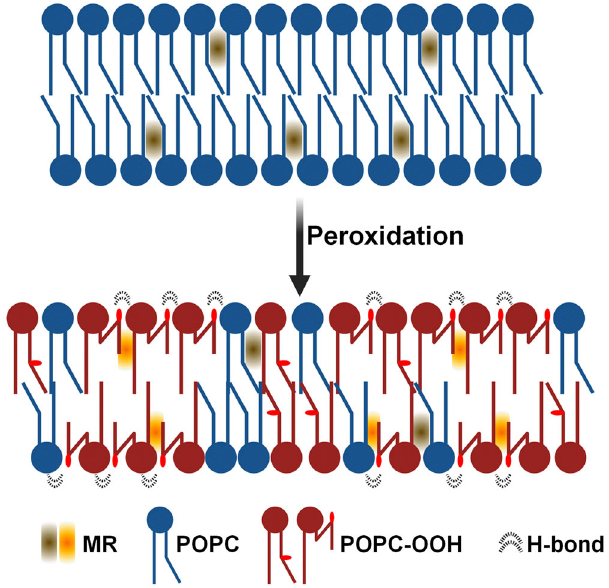
Fig. 7 Effect of lipid peroxidation on membrane architecture. Snorkelling of the lipid tails leads to an increased lipid packing towards the interface, yet this causes the increase of the individual area per lipid. Concurrently, chain snorkelling creates a “ void ” at the membrane ’ s midplane, which lead to a lower membrane thickness and elastic